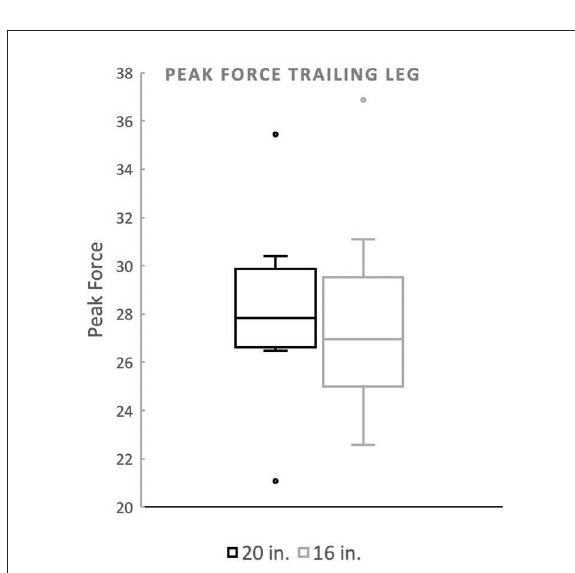
FIGURE3 Peak force of the trailing forelimb. There was no significant difference between the standard (20 ′′ ) or preferred (16 ′′ ) height for the trailing forelimb. The dots noted outside the box plot are outliers.